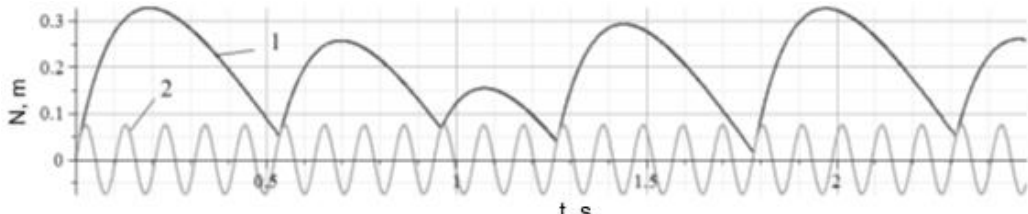
Fig. 3. A characteristic trajectory of tossing with flight of a particle through several periods. 1 - trajectory of tossing of the particle. 2 - trajectory of the oscillation surface with amplitude A=0.74 m.,  =60 rad./s., p=14 kg/s.